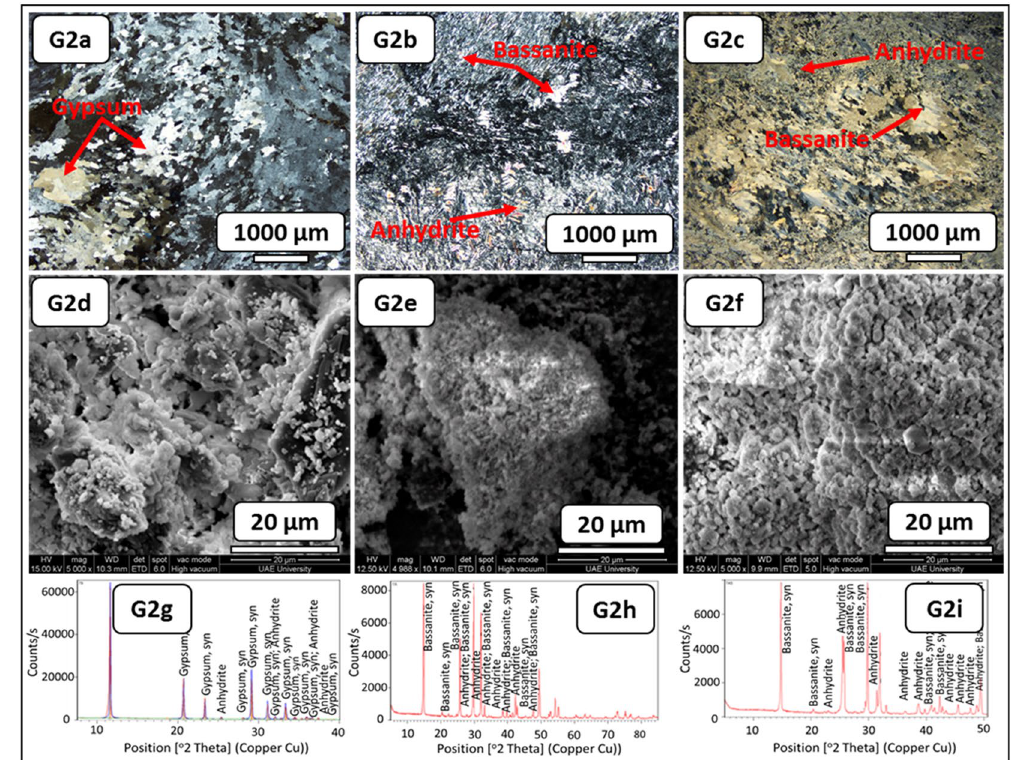
Figure 8. Microscopic description, SEM and XRD of an evaporitic rock Group 2 (fresh sample, after slaking with distilled water and groundwater respectively). G2a-G2c represents thin section images under cross- polarized microscope showing meso-crystalline gypsum with minor anhydrite crystals before SDI and alignment of microcrystalline fibrous bassanite and anhydrite crystals after SDI test. G2d-G2f. represents SEM images showing gypsum aggregates network before SDI changed to fibrous anhydrite, bassanite crystals and aggregates after SDI test. G2g-G2i represents XRD analyses showing dominant of gypsum with some anhydrite before SDI test whereas after SDI dominance of bassanite and